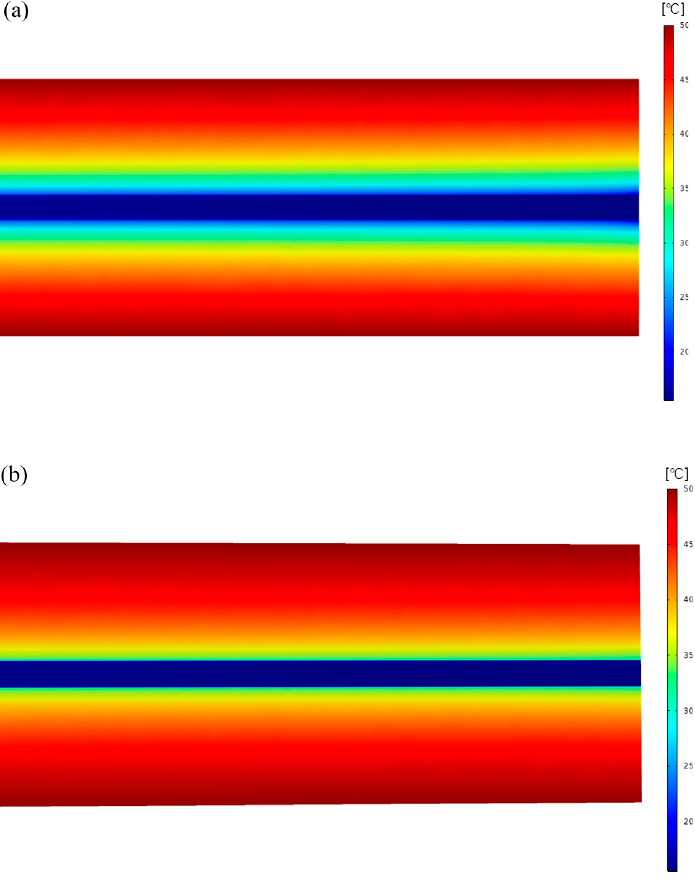
Figure 14. Longitudinal section cloud diagram of temperature field of surrounding rock: ( a ) Temperature field cloud of plain mortar supported tunnel. ( b ) Temperature field cloud of insulated mortar supported tunnel.